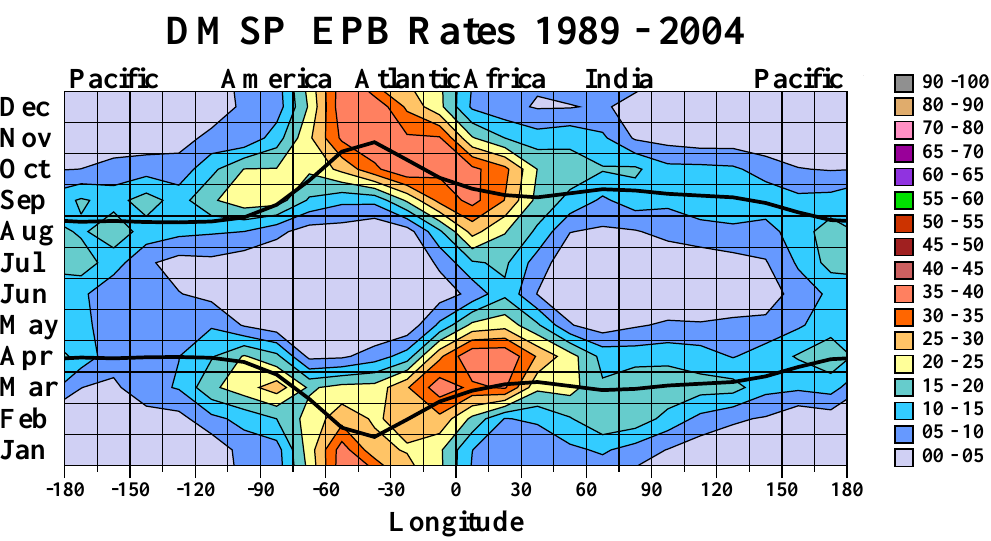
Fig. 3. Contour plot representing EPB rates for 1989–2004 on a month versus longitude grid. Colors represent the rates as indicated. Black lines mark the two times per year when α =0 ◦ within each longitude bin.